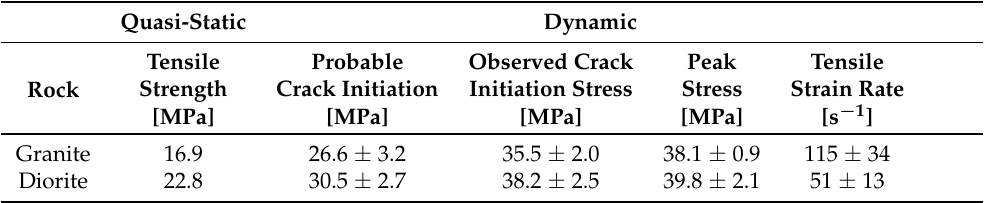
Table 5. Summary of quasi-static and dynamic indirect tensile